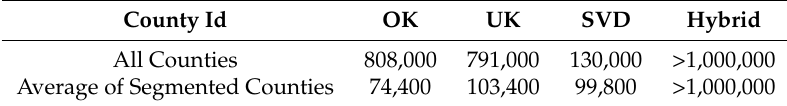
Table 1. Mean Absolute Error (MAE) in USD for baseline approaches, including Ordinary Kriging (OK), Universal Kriging (UK), Singular Value Decomposition (SVD), and the Hybrid Algorithm presented in